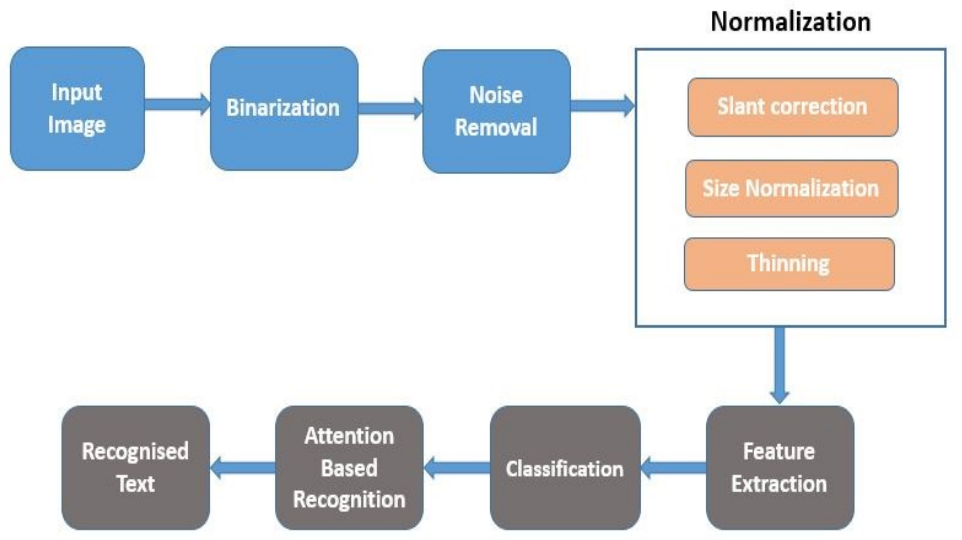
Figure 6. A flowchart of the text recognition process.